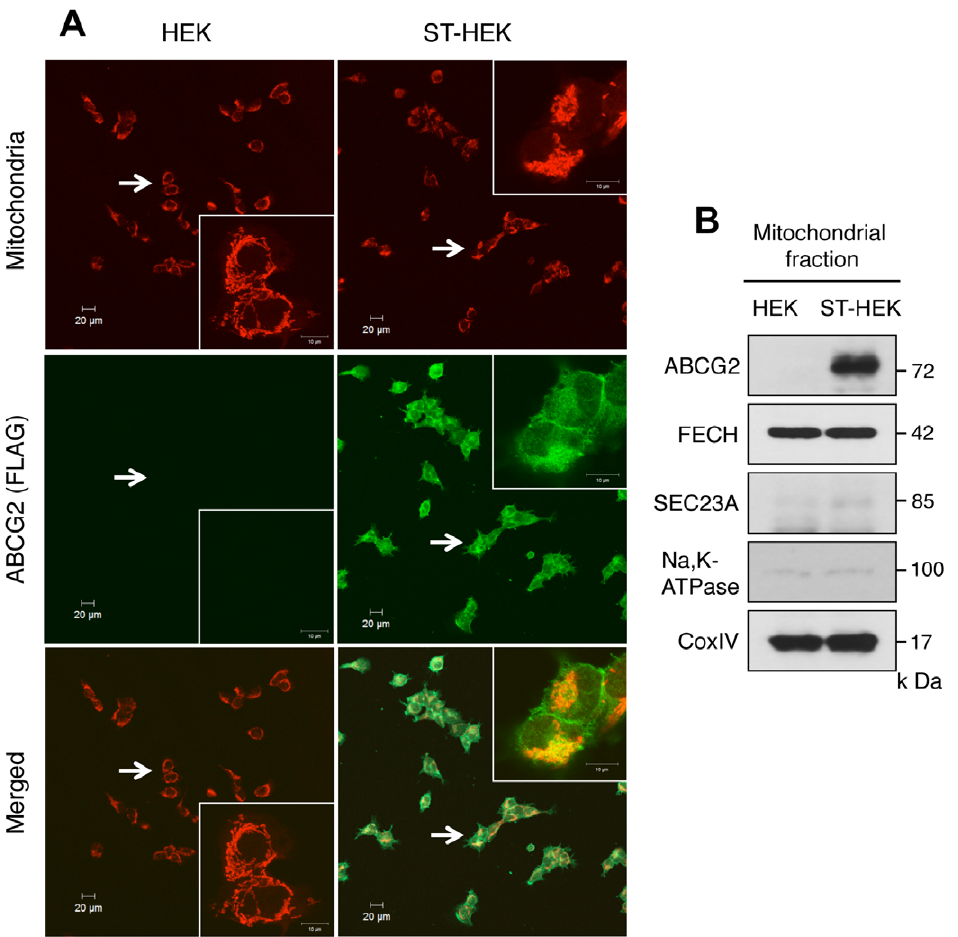
Figure 6. Expression and distribution of FLAG-ABCG2 in HEK cells and ST-HEK cells. A, Confocal immunofluorescence analysis of HEK cells and ST-HEK cells. Mitochondria, stained with Mito Tracker Red CMXRos; ABCG2, stained with monoclonal anti-FLAG IgG and Alexa Fluor 488- conjugated goat anti-mouse IgG. B, Western blotting analysis of mitochondrial fraction of HEK cells and ST-HEK cells. A representative blot of multiple experiments is shown.